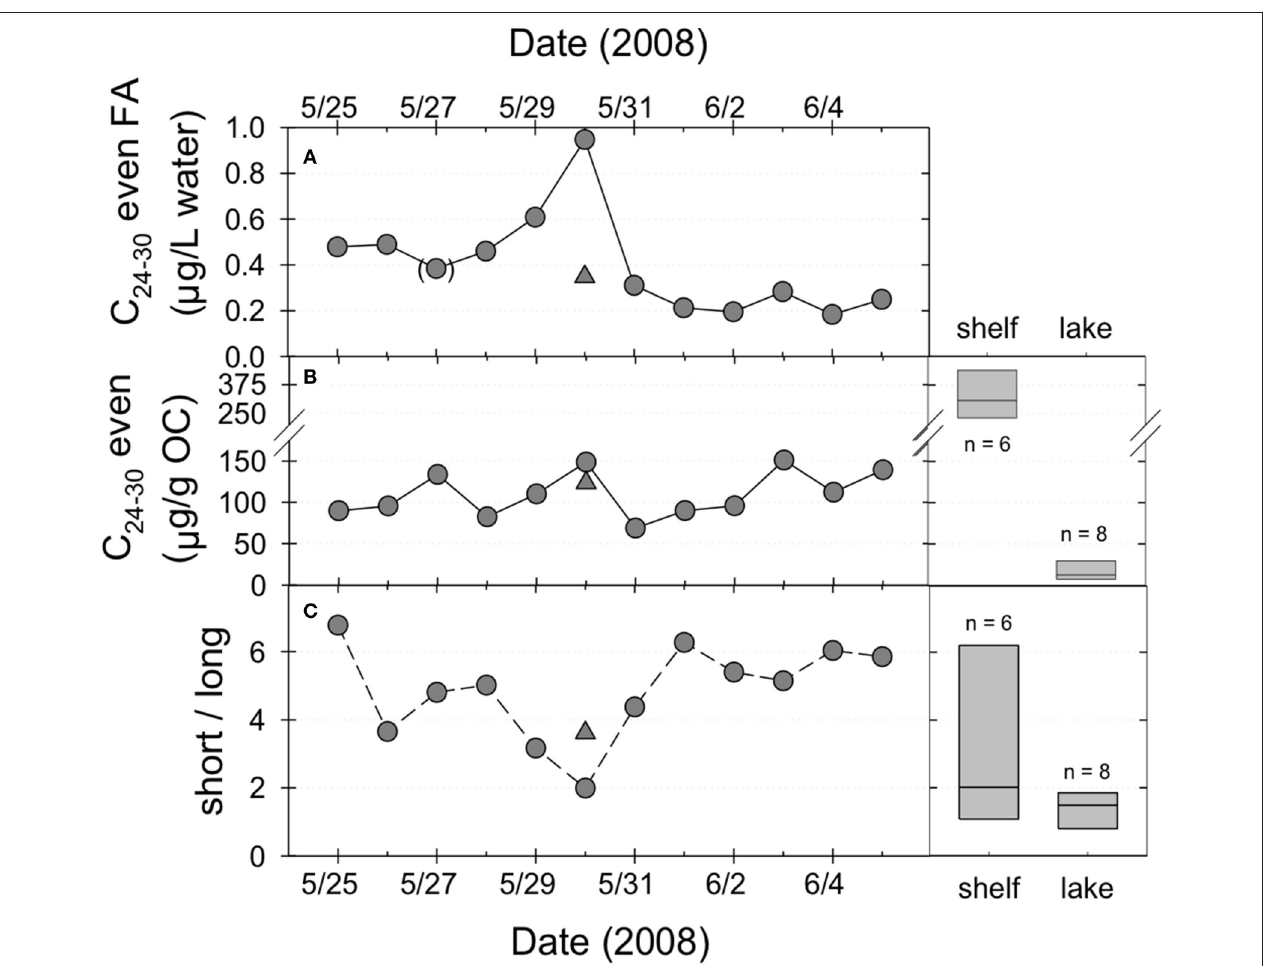
FIGURE 9 | Fatty acid composition data, including (A) long-chain (even) plant wax fatty acid concentration per liter water, (B) yields of long-chain (even) plant wax fatty acids from suspended sediments normalized per mass OC, and (C) the ratio of short (C 16 and C 18 ) to long (C 24 , C 26 , C 28 , and C 30 ) fatty acids, plotted by date, with Inuvik samples indicated by circles and the Tsiigehtchic sample marked by a triangle. The data point shown in parentheses (lipids on May 27) is more uncertain than the others because a less accurate method was used to measure filtration volume on this day. Data for continental shelf sediments (from Drenzek et al., 2007) and lake sediments are shown on the right. Box-and-whisker plot details as described in the caption for Figure 5